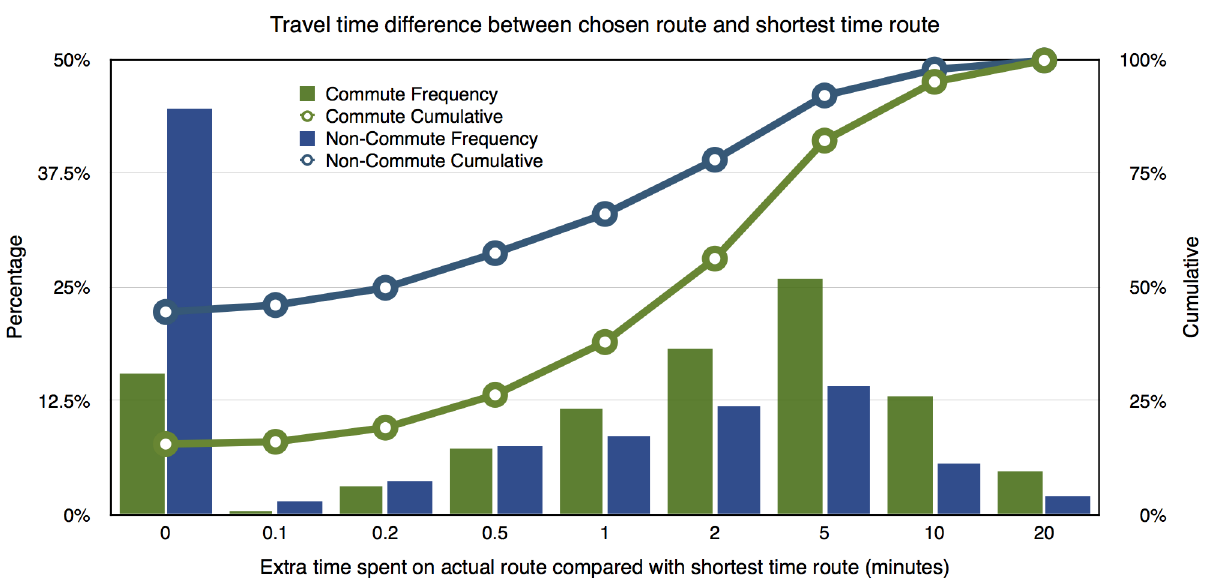
Fig 3. Comparison in travel time between actual commute/non-commute trip route and corresponding shortest time route.